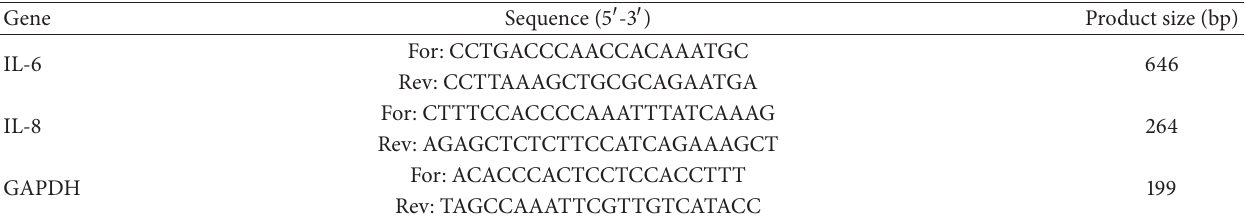
Table 1: Primers used in this